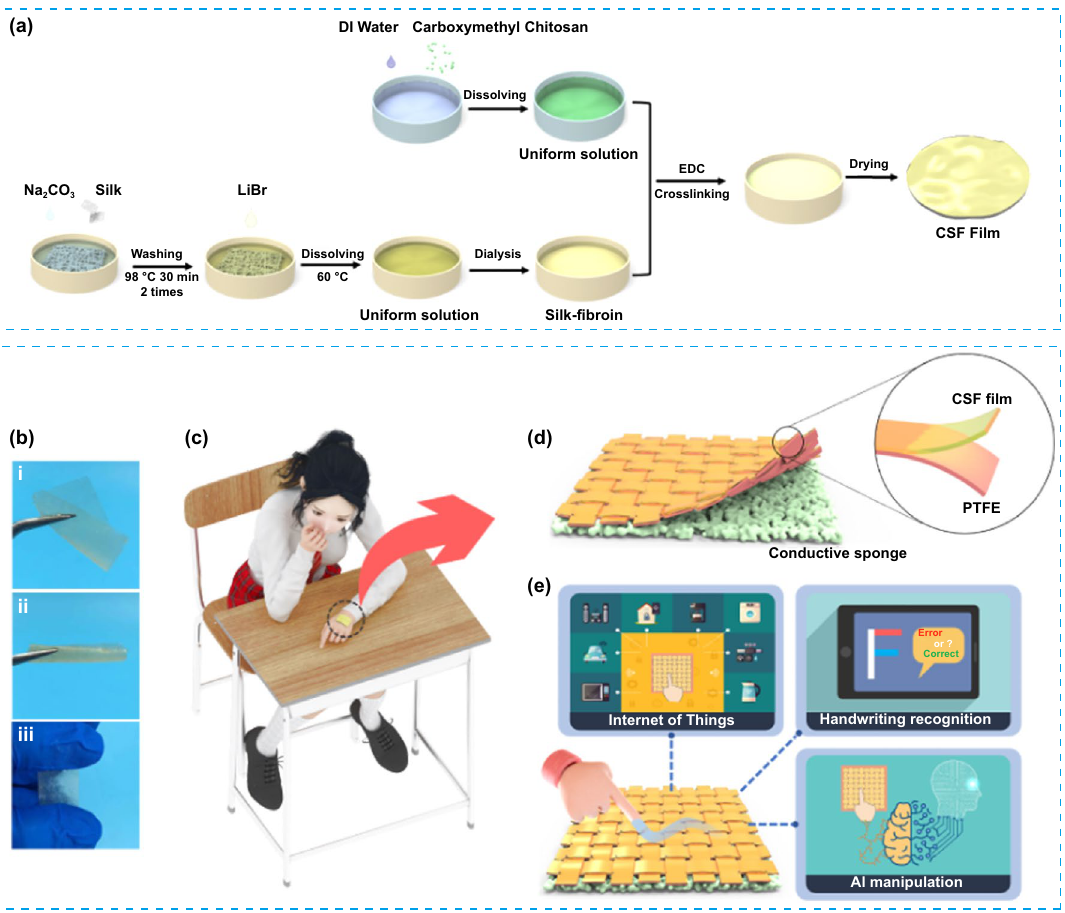
Fig. 1 Schematic illustration for preparation process and potential application scenarios. a Schematic showing fabrication steps of CSF film. b Photograph of twist and stretching of CSF film. c–e Schematic diagram of CSF-TENG for HMI, handwriting recognition, and AI